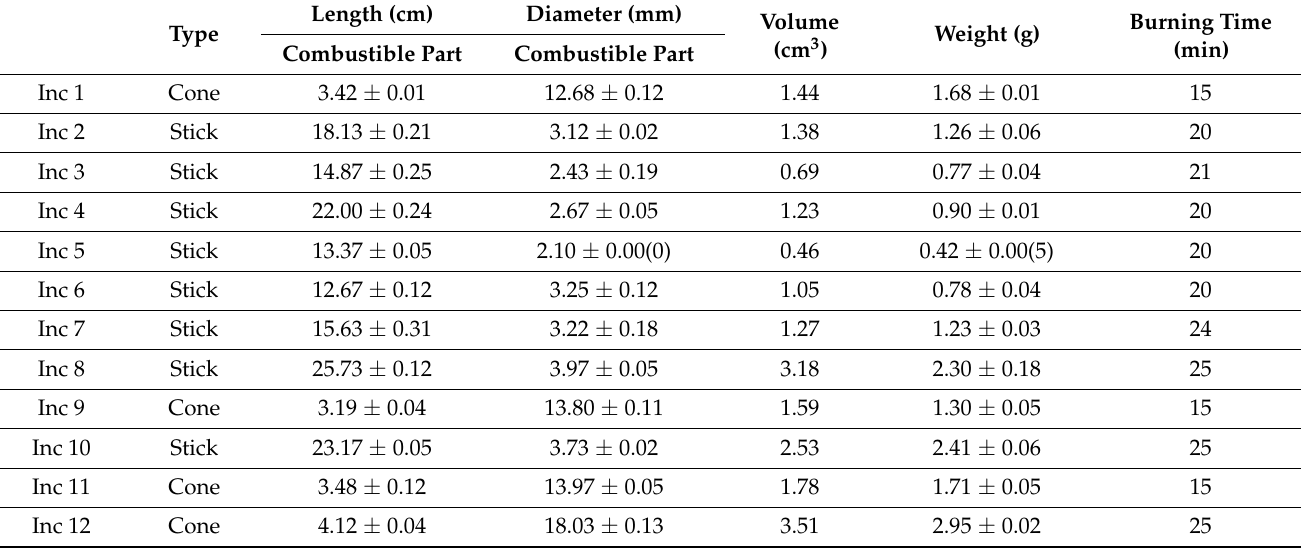
Table 1. Physical characteristics of the incense